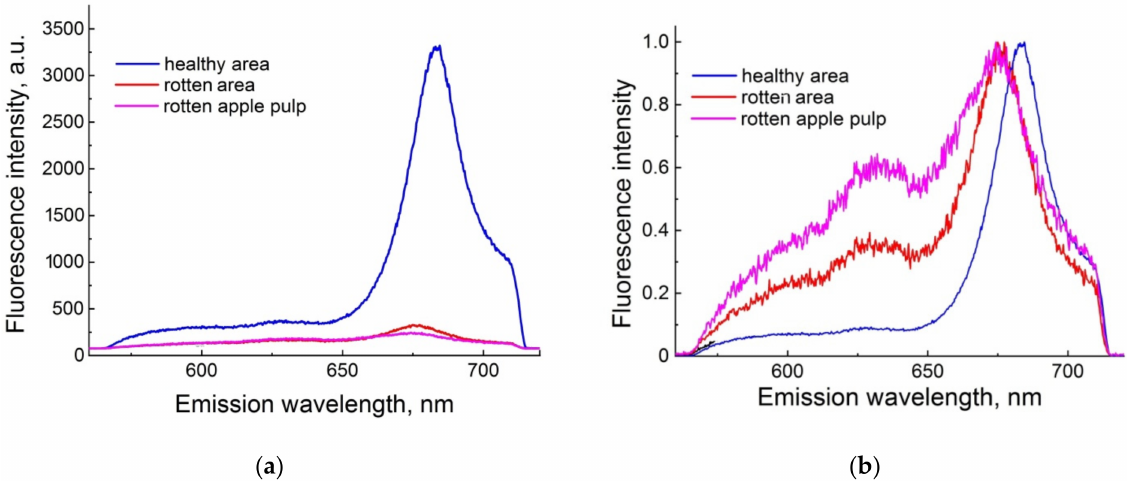
Figure 9. Pulsed fluorescence spectra of healthy and rotten green apples: ( a ) original spectra; ( b ) normalized spectra.